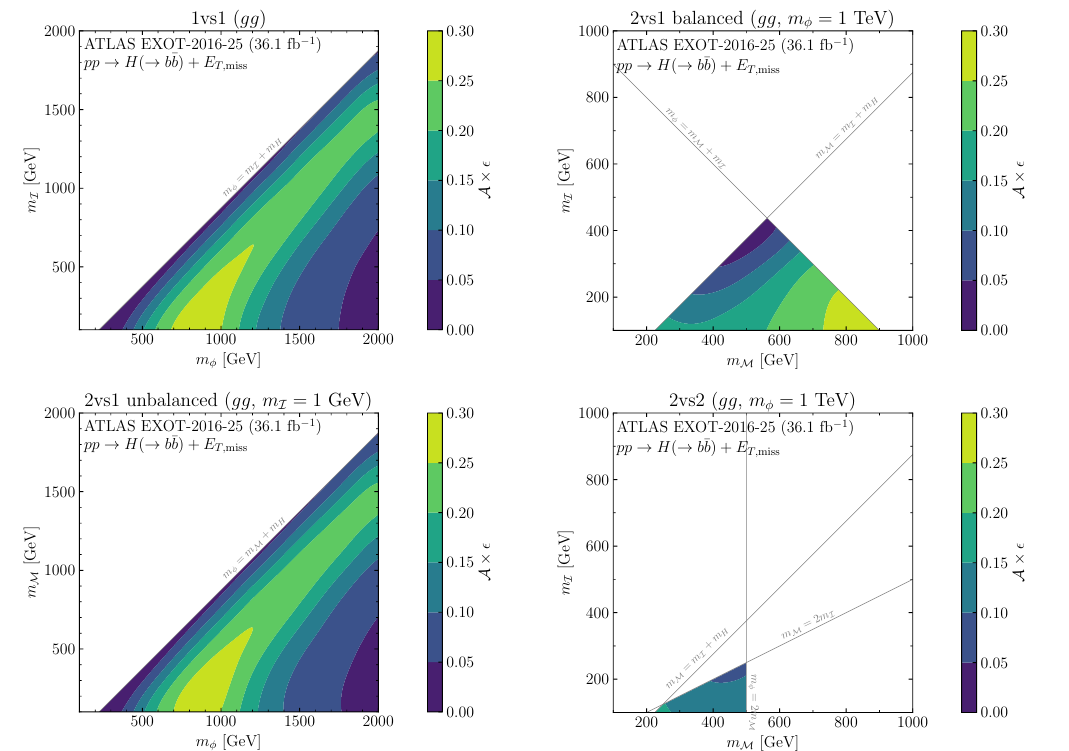
Figure 16. Acceptance × efficiency maps for the gg -initiated mono-Higgs plus E miss model topologies derived by recasting the ATLAS mono-Higgs plus E miss results are shown in the ( m φ , m I ) parameter plane for the 1vs1 topology (upper left panel), in the ( m M , m I ) parameter plane for the 2vs1 balanced topology (upper right panel), in the ( m φ , m M ) parameter plane for the 2vs1 unbalanced topology (lower right panel), and in the ( m M , m I ) param- eter plane for the 2vs2 topology (lower right panel). The kinematic constraints for each topology are depicted by gray